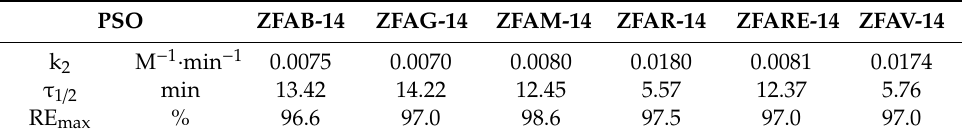
Figure 7. Regression analyses of the experimental data by pseudo first- (PFO) and second- (PSO) order kinetic models (linear plots). Table 3. Parameters of pseudo-second-order kinetic model for adsorption of Malachite green onto fly ash zeolite surface and the obtained removal efficiencies.